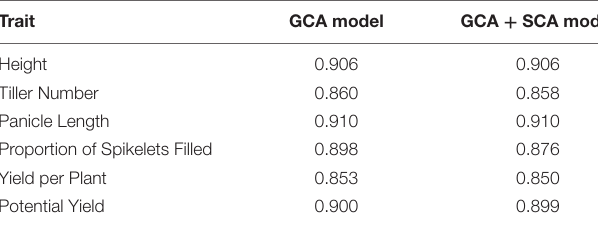
TABLE 7 | Accuracies of phenotypic selection for female GCA.